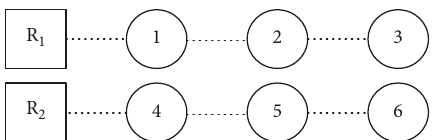
Figure 14: Two three-hop networks for the coexistence scenario.